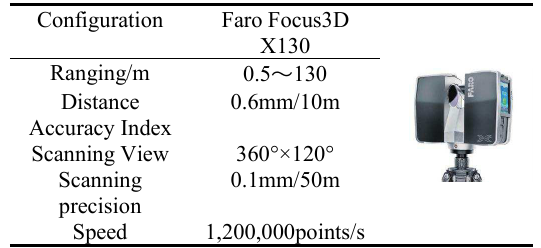
Table 2. Faro Focus 3D X130 scanner and main technical indicators